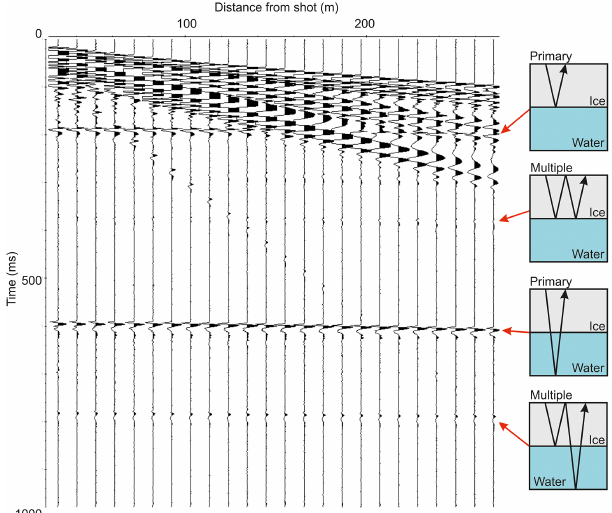
Figure 2. Example hammer and plate seismic shot gather with read- ily identified primary seismic reflections and multiples. The primary ice base reflection at 190ms is masked by ground roll signal at the far